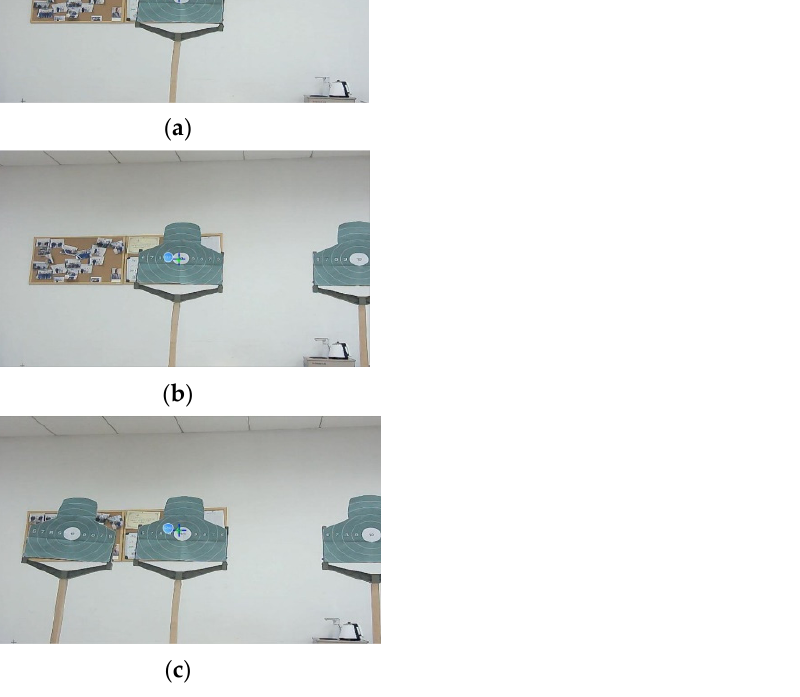
Figure 18. Aiming process of target. ( a ). Aiming target; ( b ). The appearance of the first interference target when aiming; ( c ). The appearance of the second interference target when aiming. Figure 19 shows the distribution of gaze points in the experimental visual aiming process. Figure 19a is the distribution of gaze points of the original output, and Figure 19b is the distribution of gaze points after classification.